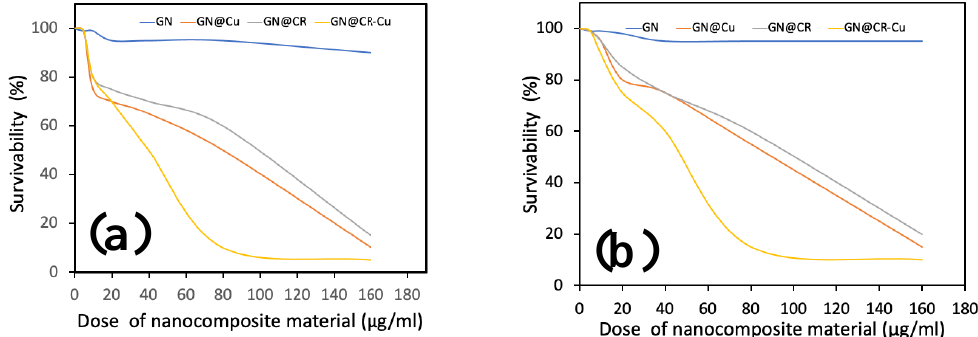
Figure 8. The survivability of E. coli ( a ) and P. aeruginosa ( b ) in the presence of nanocomposite material. Image showing excellent dose-response, increasing concentration significantly retards bacterial growth.